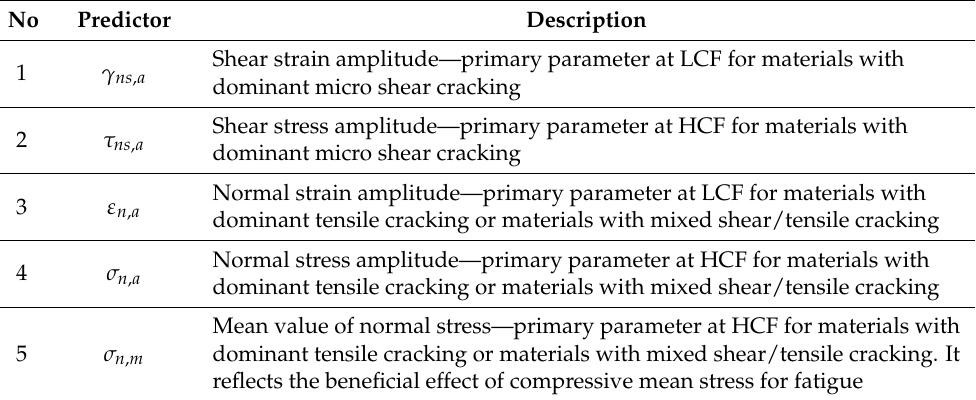
Table 1. Primary predictors for fatigue life of metallic